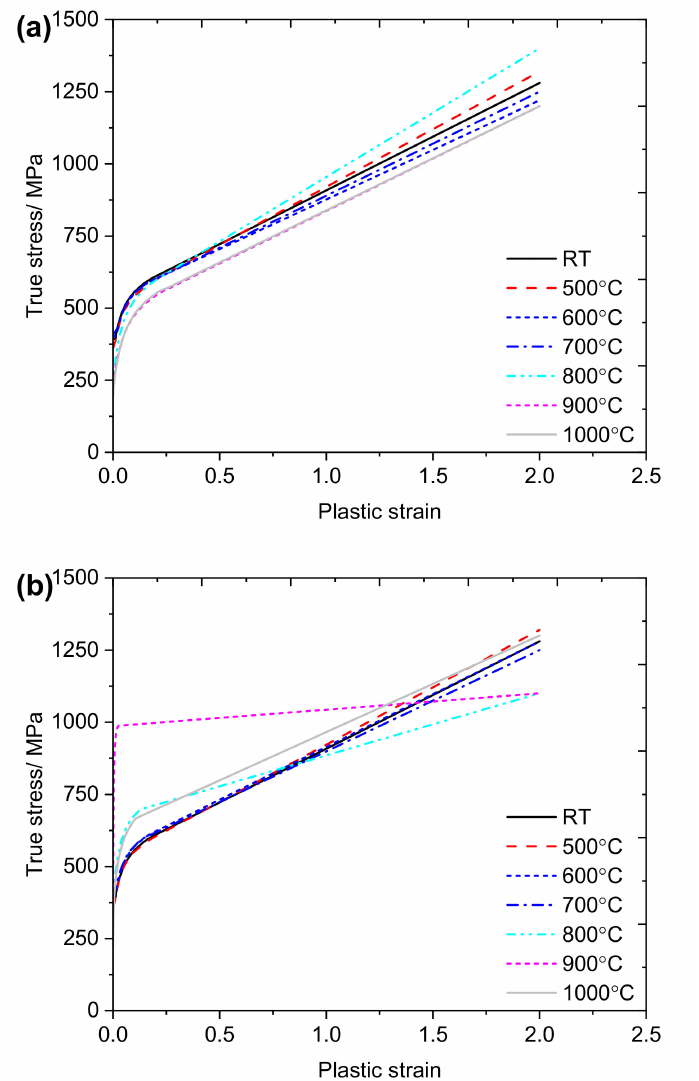
Figure 4. True stress–plastic strain relationship for ASTM A572 Gr. 50 after heating to elevated temperatures and cooling, ( a ) in air, and ( b ) in